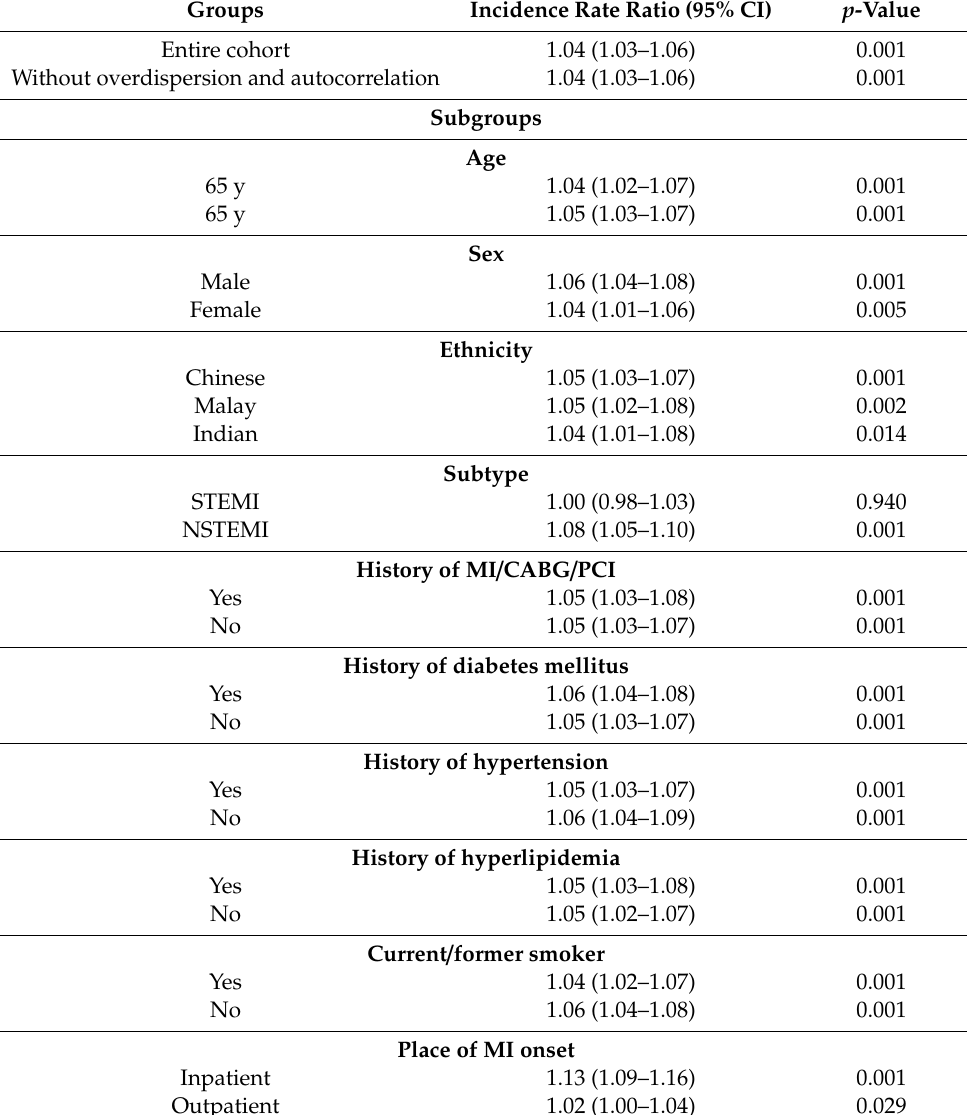
Table 2. Estimated incidence rate ratio of myocardial infarction for each 30-unit increment in pollutant standards index for the entire study cohort and by subgroups of demographic and clinical characteristics ( n = 2191 Days). Table reproduced with explicit permission from the authors of